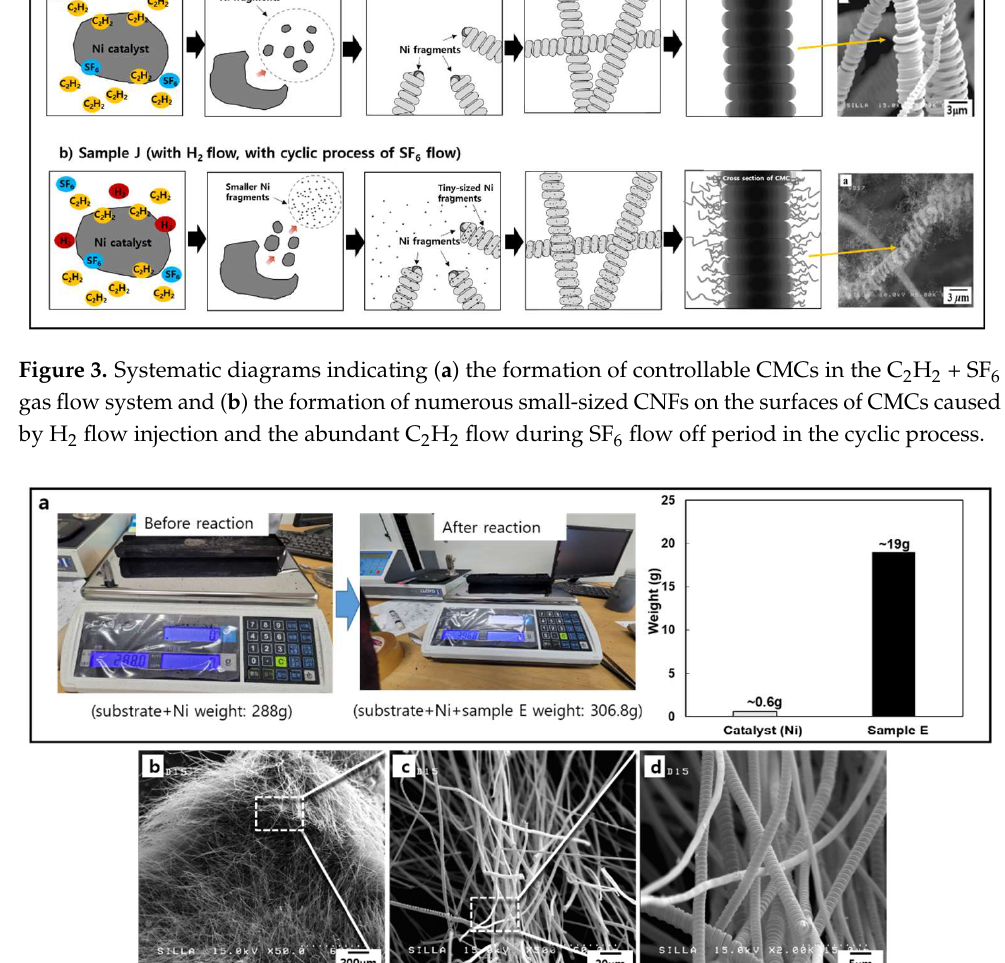
Figure 4. ( a ) Optical photograph for the weighting of sample E, ( b ) FESEM image of sample E, ( c ) magnified-FESEM image of Figure 4b, and ( d ) high magnified-FESEM image of Figure 4c.